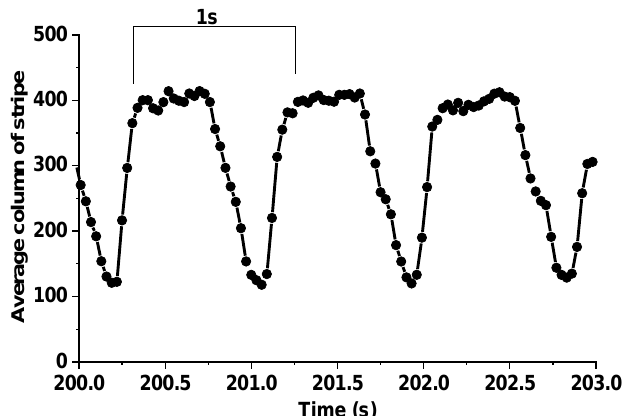
Figure 14. Motion curve for the liver of rat under anesthesia. The black dots represent the experimental results, while the solid line represents the predicted motion curve. The amplitude and frequency of the motion are roughly about 1.37 mm and 1 Hz respectively.